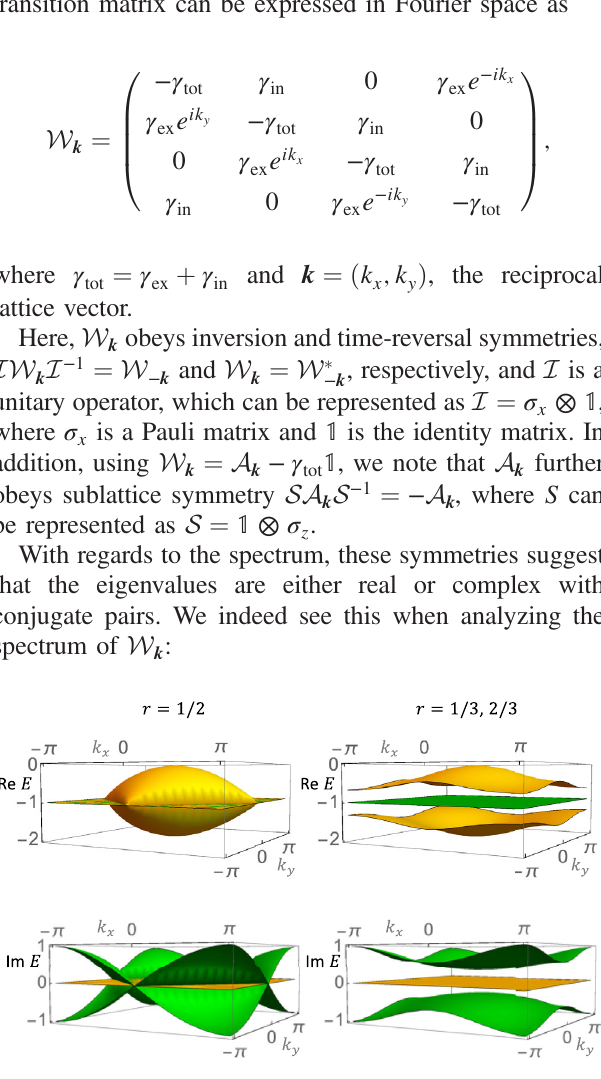
FIG. 10. Band structure of W k in the fully chiral case. The bands (or spectrum) E ð k Þ can be exactly solved for the periodic system [see Eq. (B2)], where the top E and bottom E − ; bands þ ; þ þ and E − ; − are in green. are in yellow and the middle bands E þ ; − γ ), the bands have degener- Left panel: When r ¼ 1 = 2 ( γ in ¼ ex ≠ γ acies at E ð k Þ ¼ − γ . Right panel: When r ≠ 1 = 2 ( γ ), tot in ex band gaps open in real space (top) and imaginary space (bottom) γ away from E ¼ − γ . As the spectrum is even about γ , tot in ¼ ex the same result is obtained for r ¼ 1 = 3 and 2 = 3 , which are the parameters we use. Note that the ratio r interpolates r γ between the transition probability strengths, i.e., γ ex ¼ tot 1 − r Þ γ and γ . In all panels, values of E are given in in ¼ ð tot units of γ tot